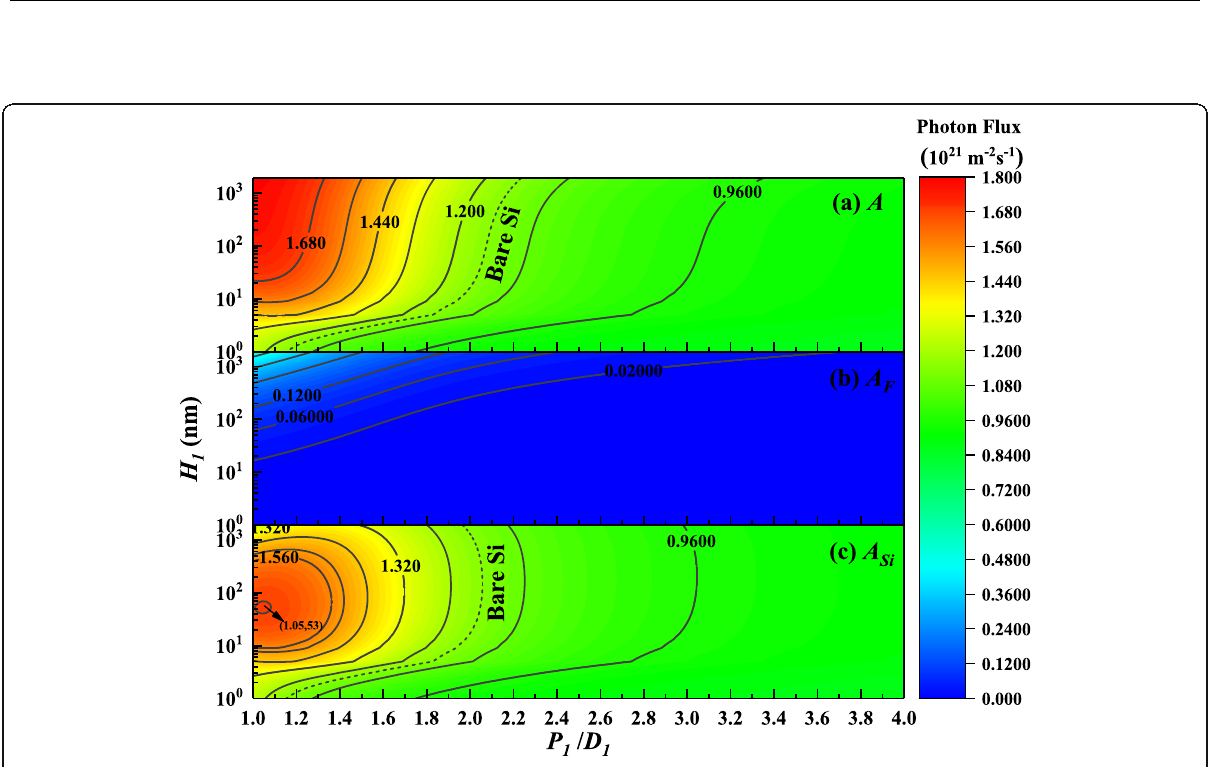
Fig. 4 Contour maps of the photon absorption distribution in different parts for FPG structure. ( a ) The total photon absorption A . ( b ) The photon absorption of the front surface gratings A F . ( c ) The photon absorption of CS part A Si . (The dotted line in the illustration represents the absorption of BCS)